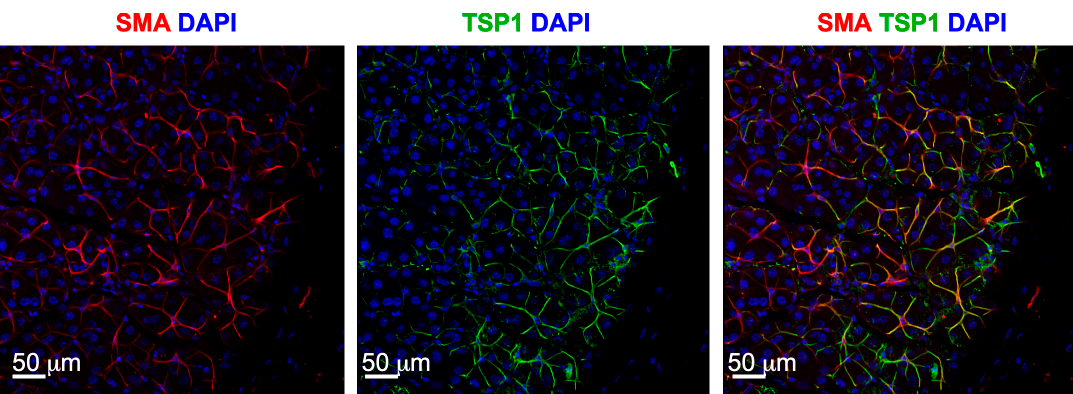
Figure 1. Myoepithelial cells in LGs express TSP-1 Fluorescence microscopic images were captured from mouse LG section immunostained for MEC marker—smooth muscle actin (SMA) in red, TSP-1 (green) and nuclear stain DAPI (blue). Images were kindly provided by Dr. Helen P. Makarenkova, Scripps Research, La Jolla, CA, USA.